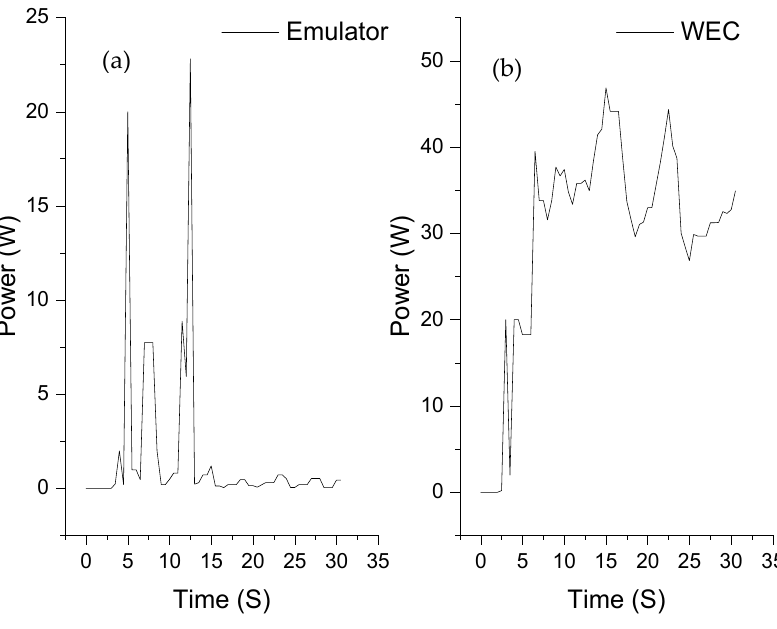
Figure 8. Output power for ( a ) emulator ( b ) WEC.